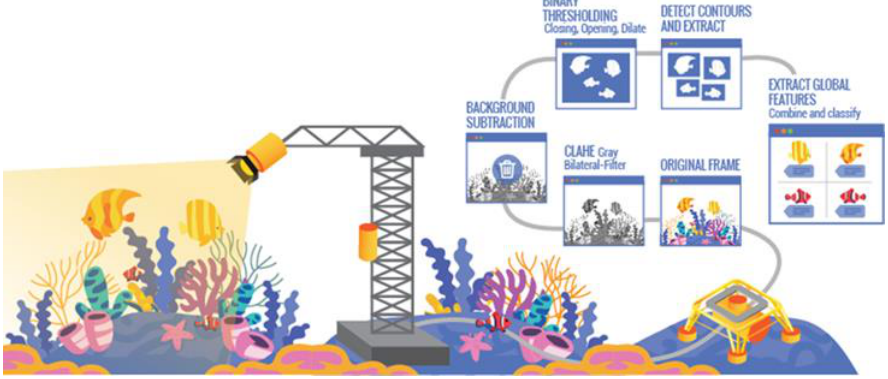
Figure 8. Designed automatic image processing pipeline for HD imaging that could also be applied to acoustic outputs.